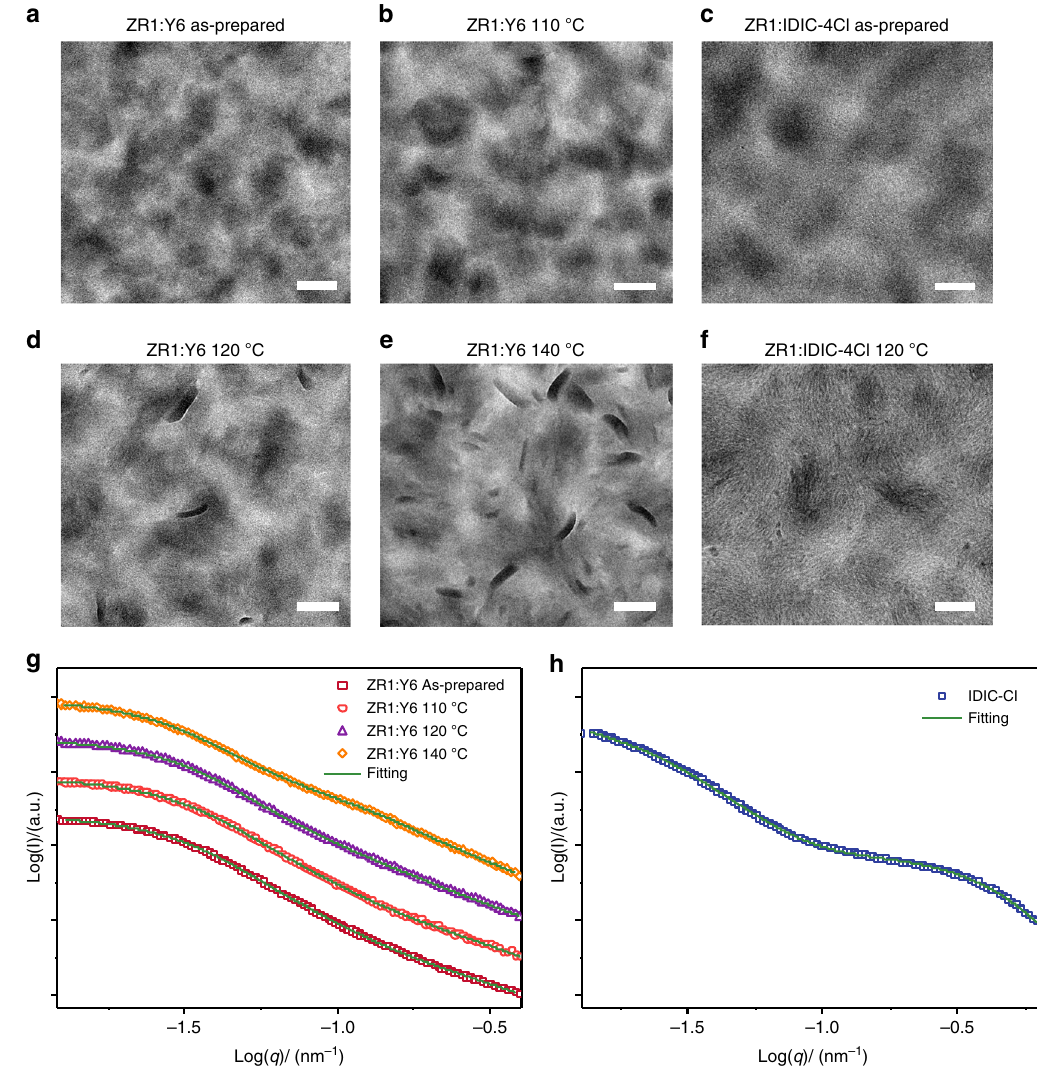
Fig. 3 Morphology analysis of ZR1:Y6 and ZR1:IDIC-4Cl blends. a – f TEM images of blends fi lms obtained at different annealing temperatures, and the scale bars are all 200 nm. g , h RSoXS pro fi les of blends fi lms.